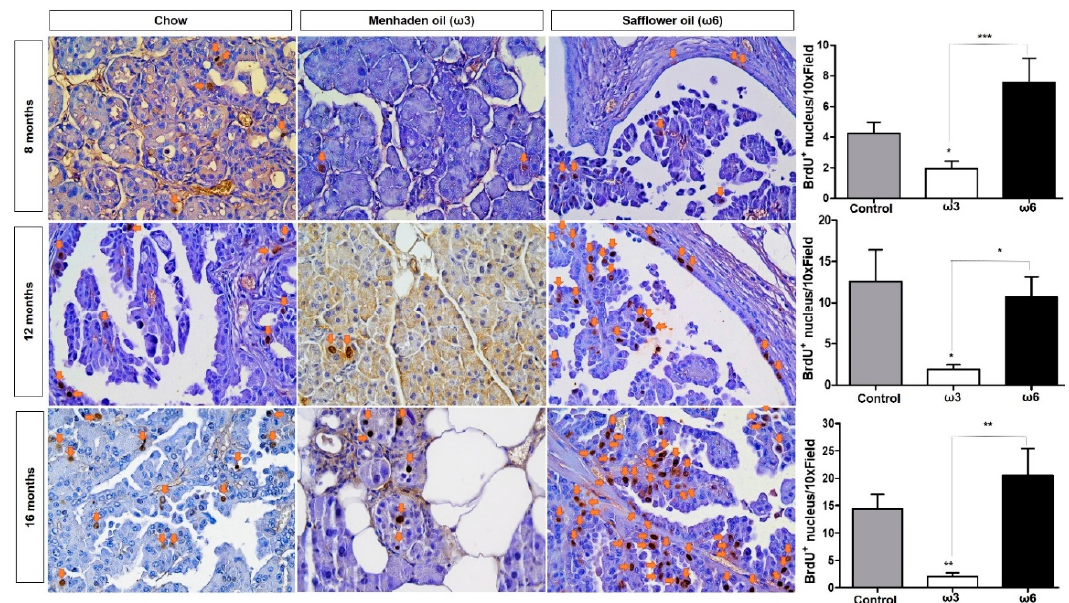
Figure 2. ω 3-enriched diets prevent proliferation in vivo. Mice were injected with Bromo-deoxyuridine (BrdU) one hour prior to collection. Cell proliferation was assessed by immunohistochemistry to identify the incorporation of BrdU into the DNA of proliferating cells. Sections stained with BrdU antibody were scored as the number BrdU-positive nuclei per high power field by two independent researchers. * p -value < 0.05: ** p -value < 0.01; *** p -value < 0.001. The asterisks above each column represent the significance compared to the control diet. The significance between both diet is indicated by connecting lines.